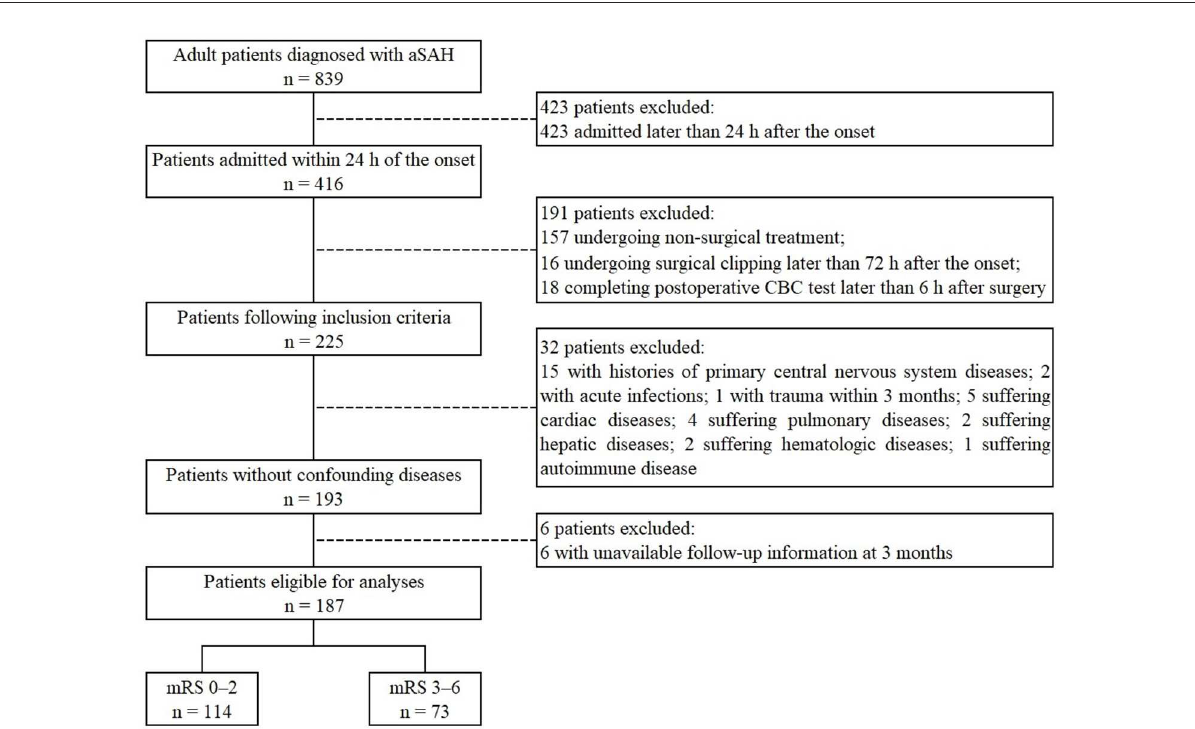
FIGURE1 Flowchart of patients included in the study. aSAH, aneurysmal subarachnoid hemorrhage; CBC, complete blood count; mRS, modified Rankin